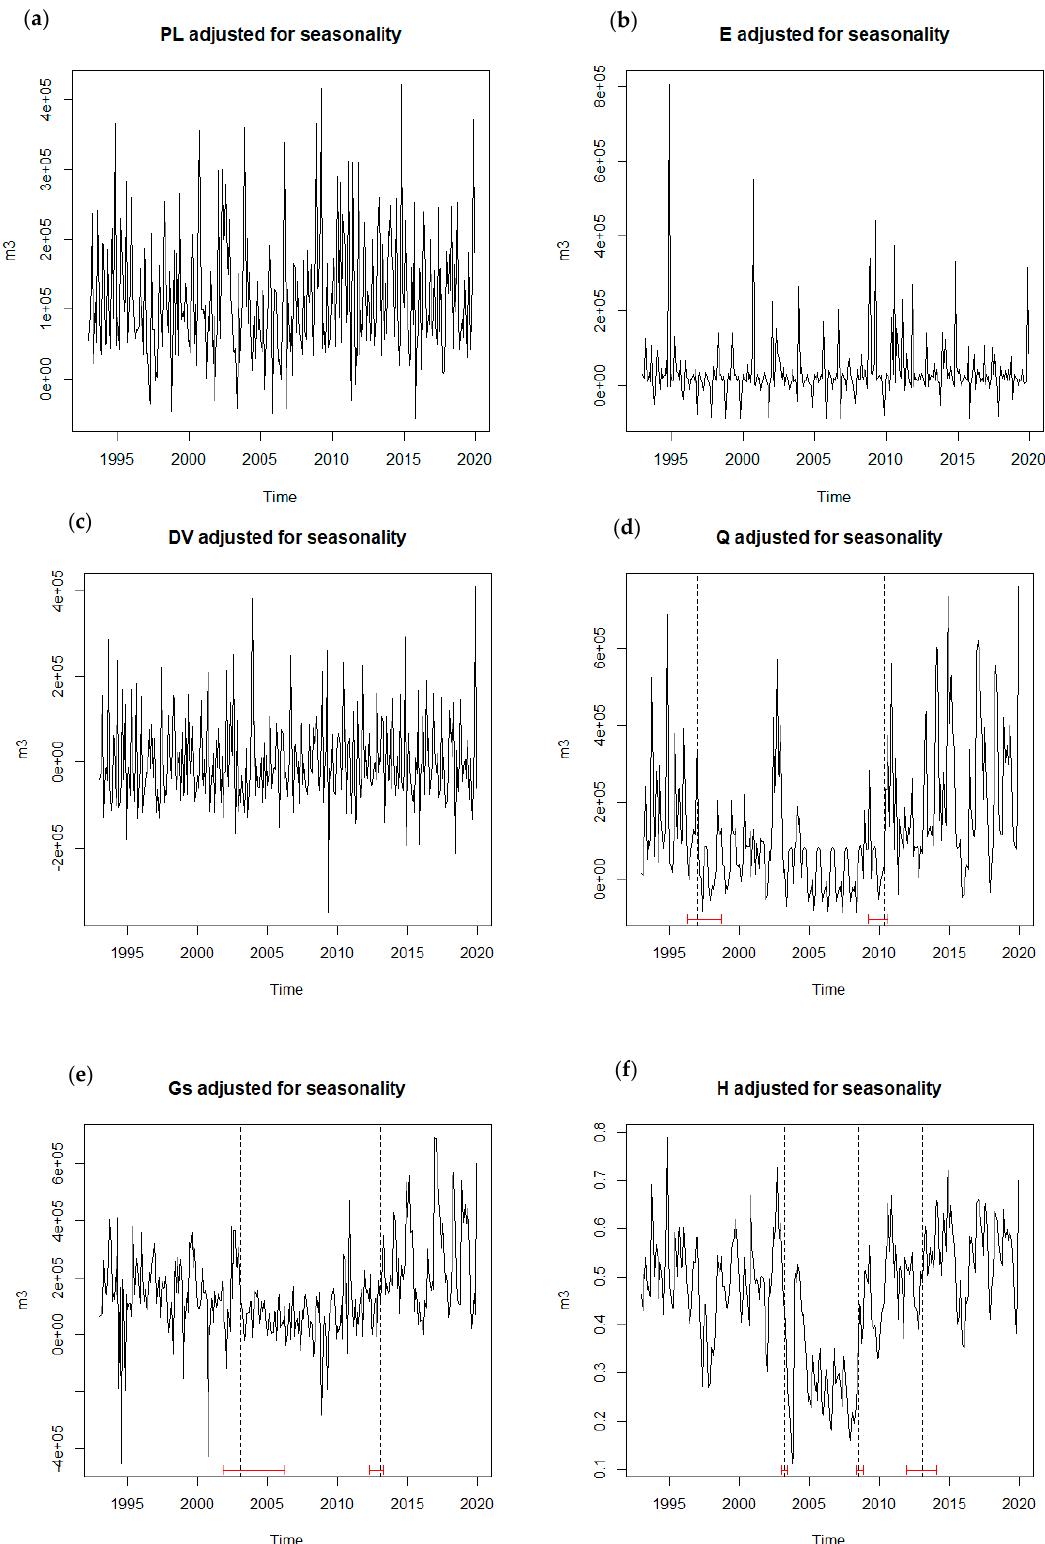
Figure 4. Main water balance terms adjusted for seasonality: ( a ) direct rainfall on lake P L , ( b ) water inflow E, ( c ) lake level variation ∆ V, ( d ) outflow from the lake Q, ( e ) groundwater source G S , and ( f ) lake level H. In addition, ( d – f ) report the break point indicated in Table 2. Table 1. Results of Mann–Kendall test applied on the main water balance terms.